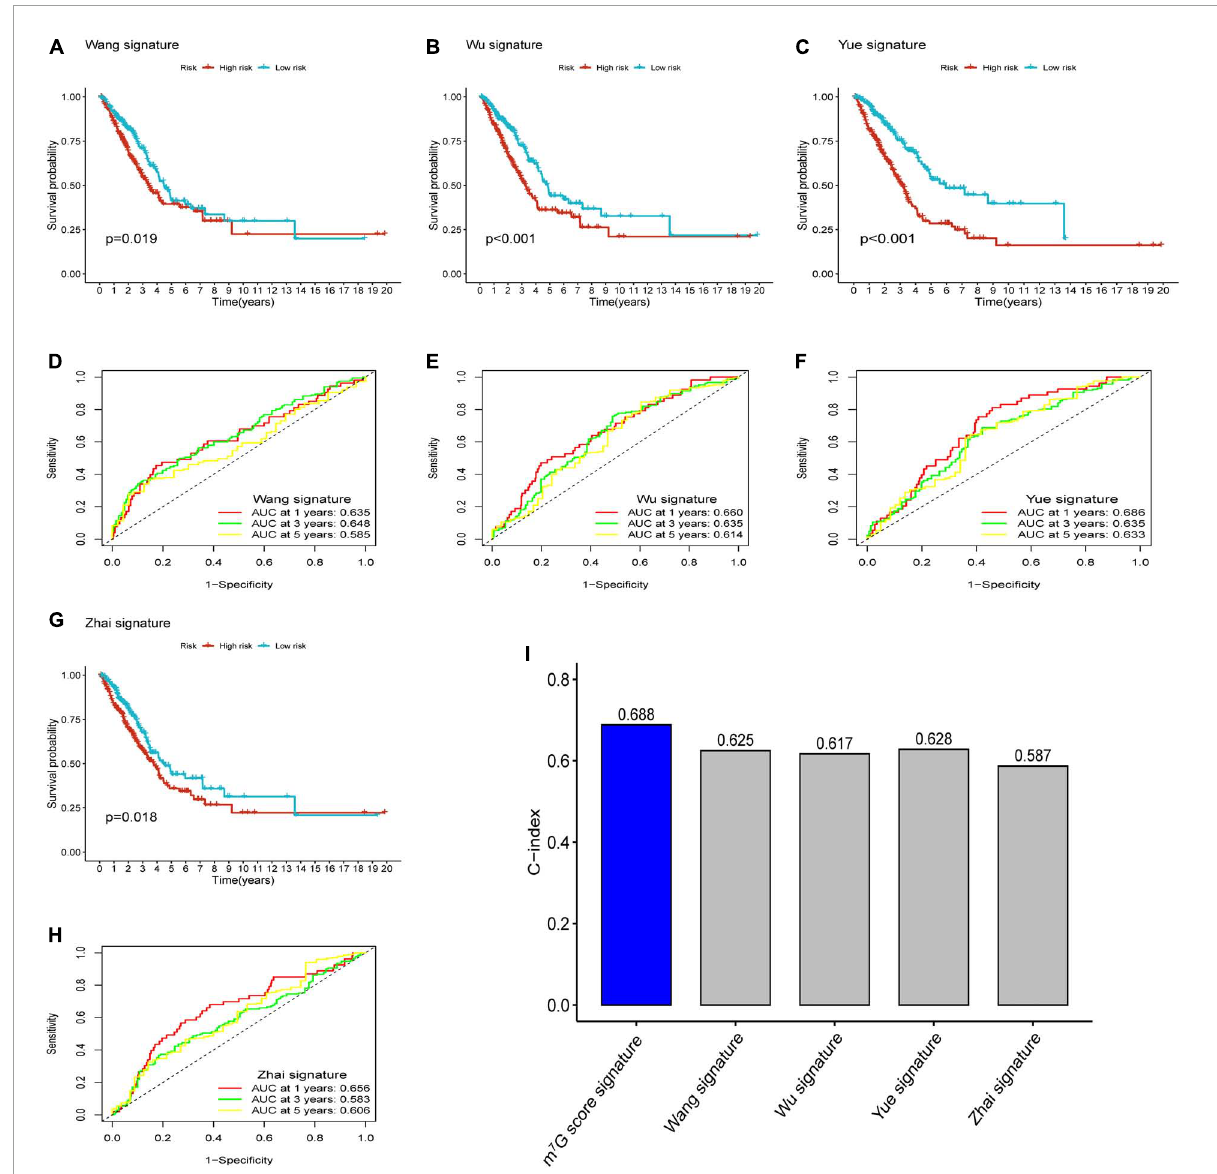
FIGURE10 Comparison of prognostic signatures. (A–C,G) Survival analysis of 5-gene signature (Wang), 4-gene signature (Wu), 3-gene signature (Yue) and 5-gene signature (Zhai). (D–F,H) AUC of 5-gene signature (Wang), 4-gene signature (Wu), 3-gene signature (Yue), and 5-gene signature (Zhai) for predicting 1-, 3-, 5-years survival rates. (I) C-index of each